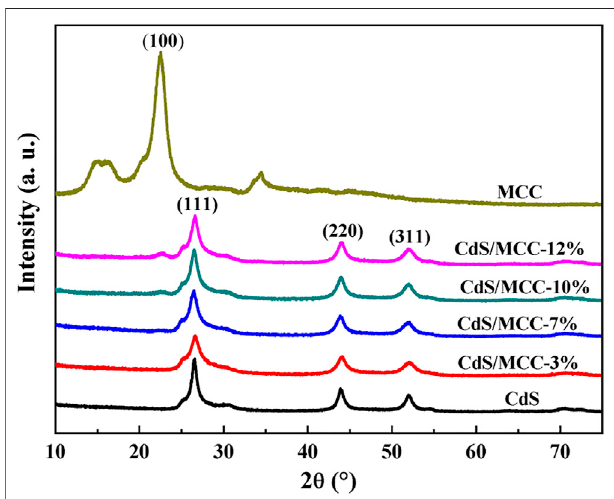
FIGURE 1 | XRD patterns of CdS, MCC, and CdS/MCC composites with different contents of